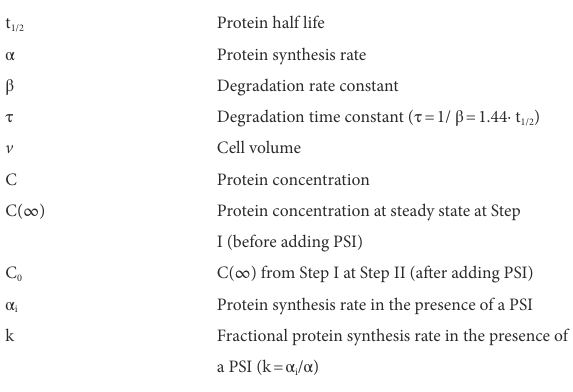
TABLE 2 Symbols used in “Expected log2(H/M) derivation from known half-lives following protein synthesis inhibition” of Materials and